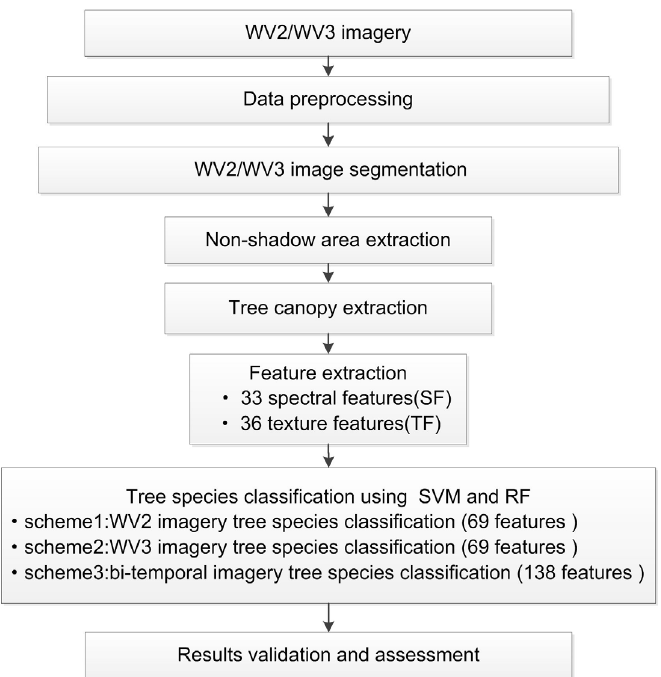
Figure 3. Flowchart of the tree species classification procedure.